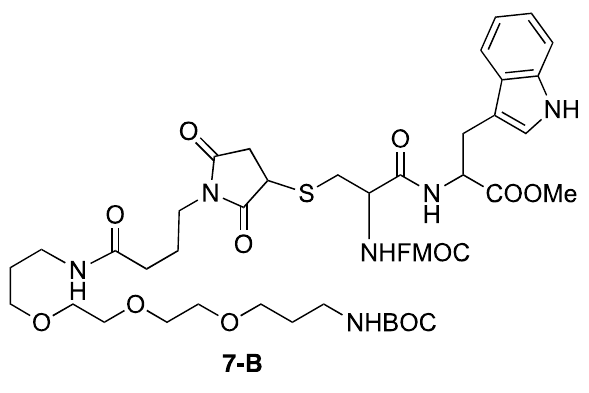
Figure 12. Intermediate 7-B . Figure 14. Intermediate 7-B .